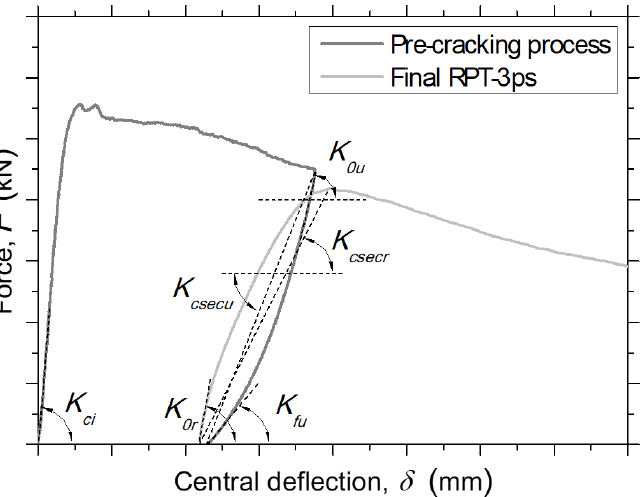
. The results obtained of the normalized stiffness parameters are pre- sented in Table 5.